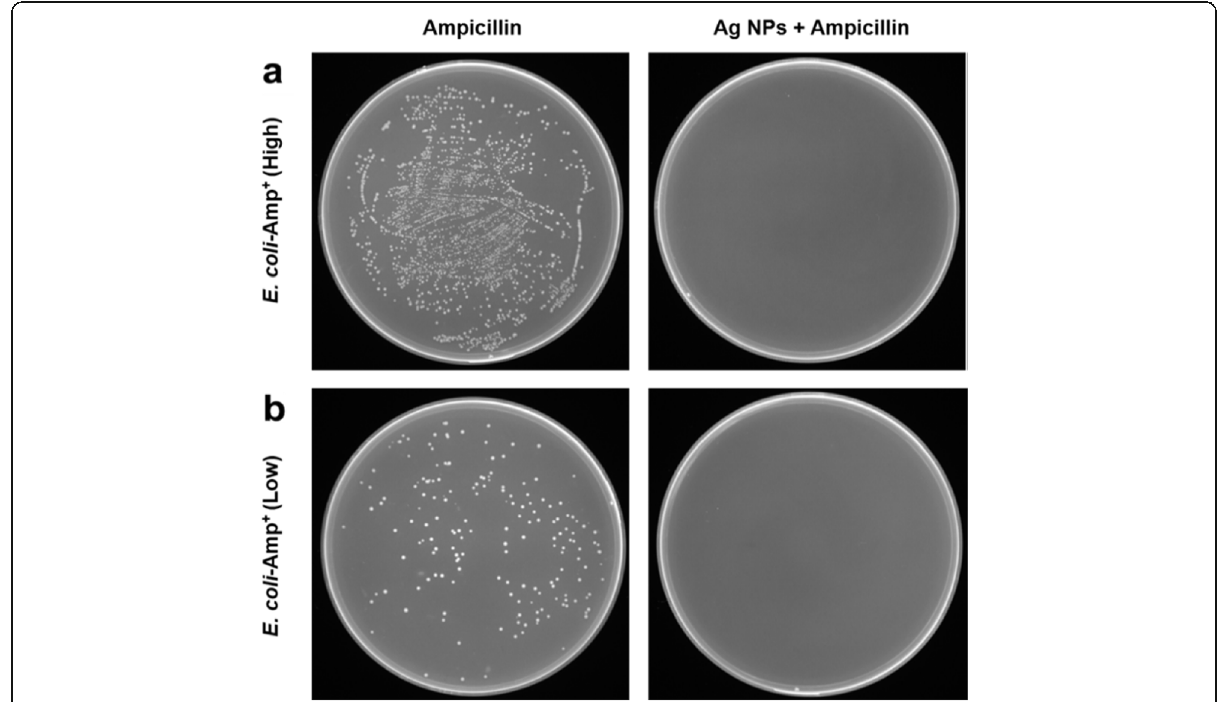
Fig. 7 The growth of E. coli -Amp + in treatment with ampicillin alone (50 μ g/mL) or in combination with Ag NPs (25 μ g/mL). a High density and b low density of E. coli -Amp +